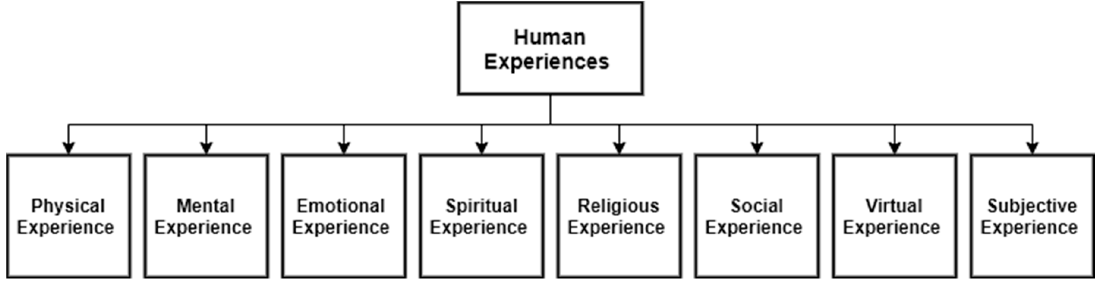
Figure 8. Human experiences in built environment [15,17,46,85–87].